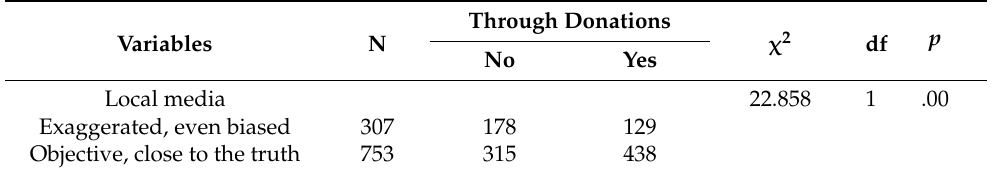
Table 8. Table of associations: reflecting the situation in the local media and personal involvement through